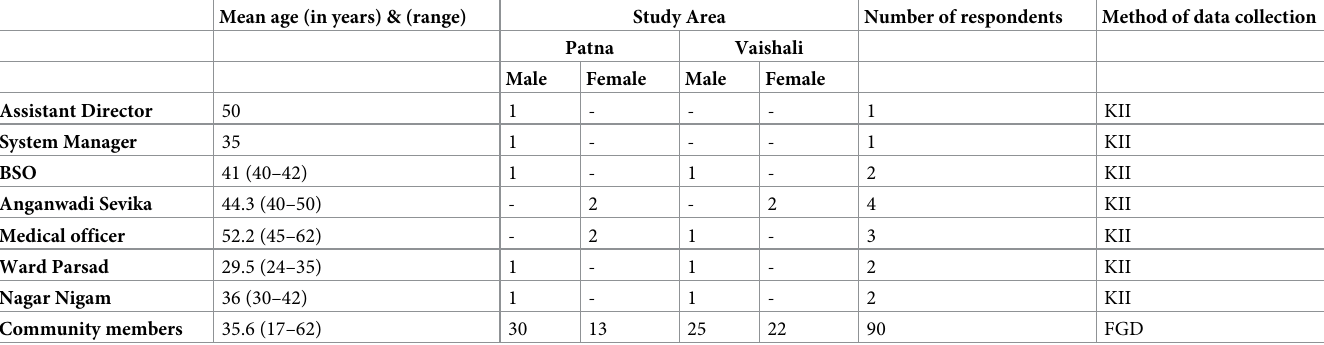
Table 1. Demographic profile of the study participants. Mean age (in years) & (range) Study Area Number of respondents Method of data collection Patna Vaishali Female